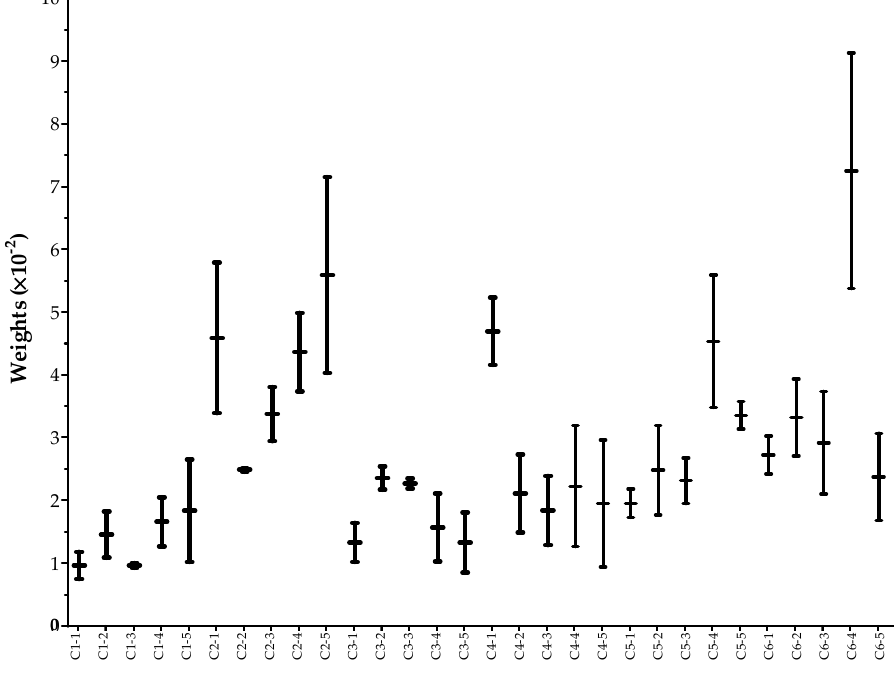
Figure 3. Grey SWARA-FUCOM weights.